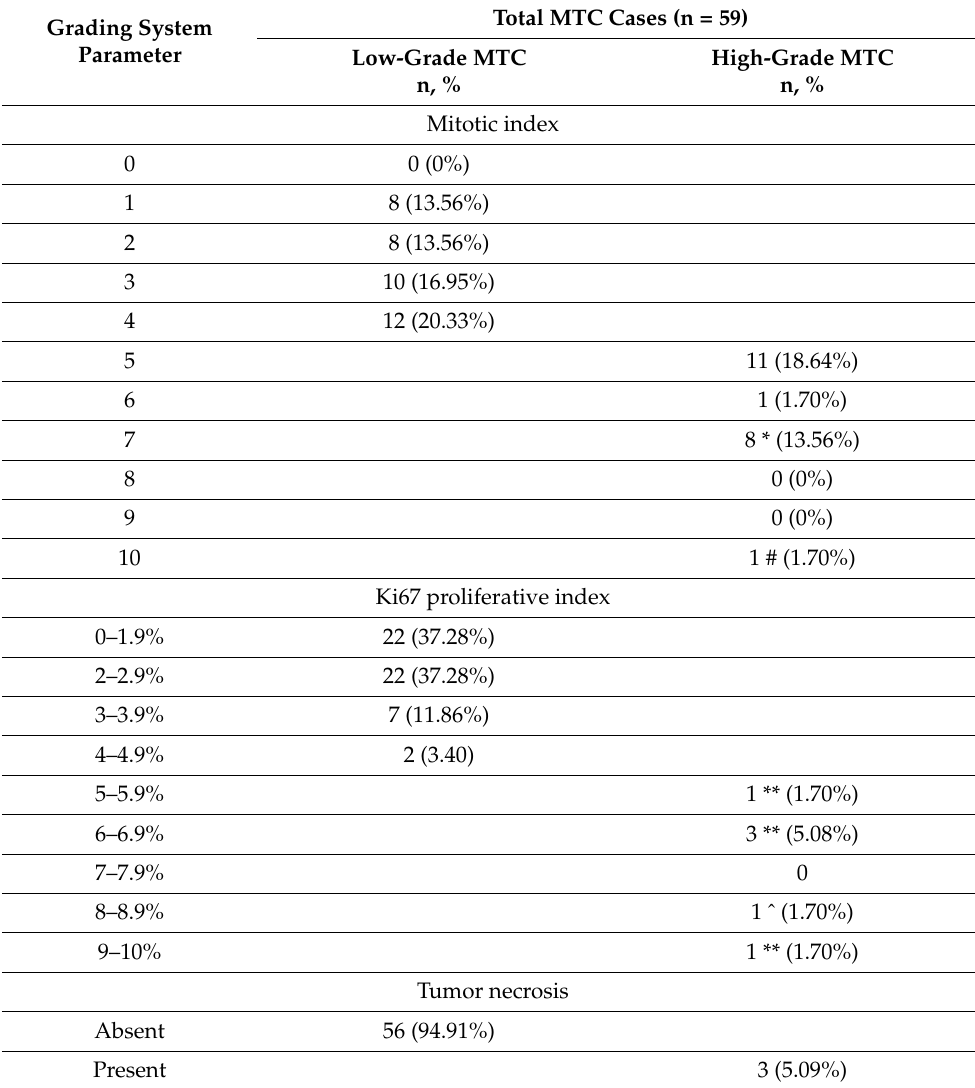
Table 3. Classification in low-grade and high-grade classes according to nternational Medullary Thyroid Carcinoma Grading